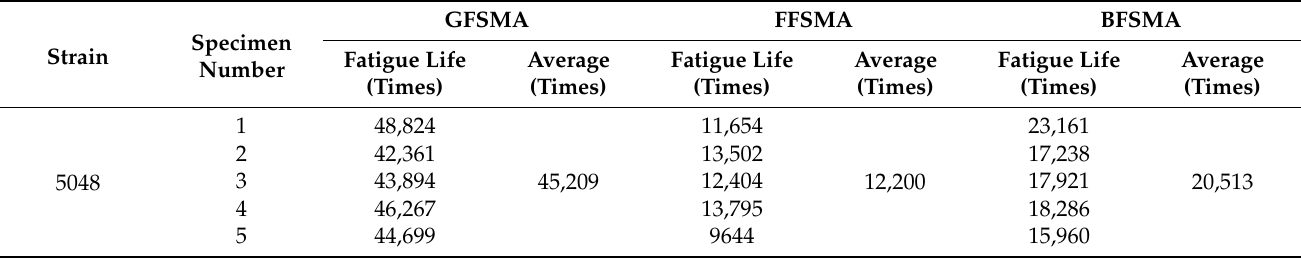
Table 6. Result of fatigue